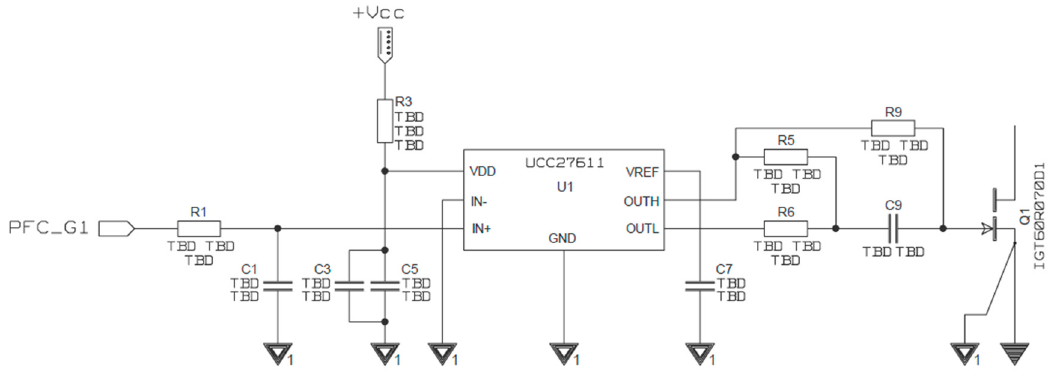
Figure 15. Principal schematic of the driving circuit for transistor